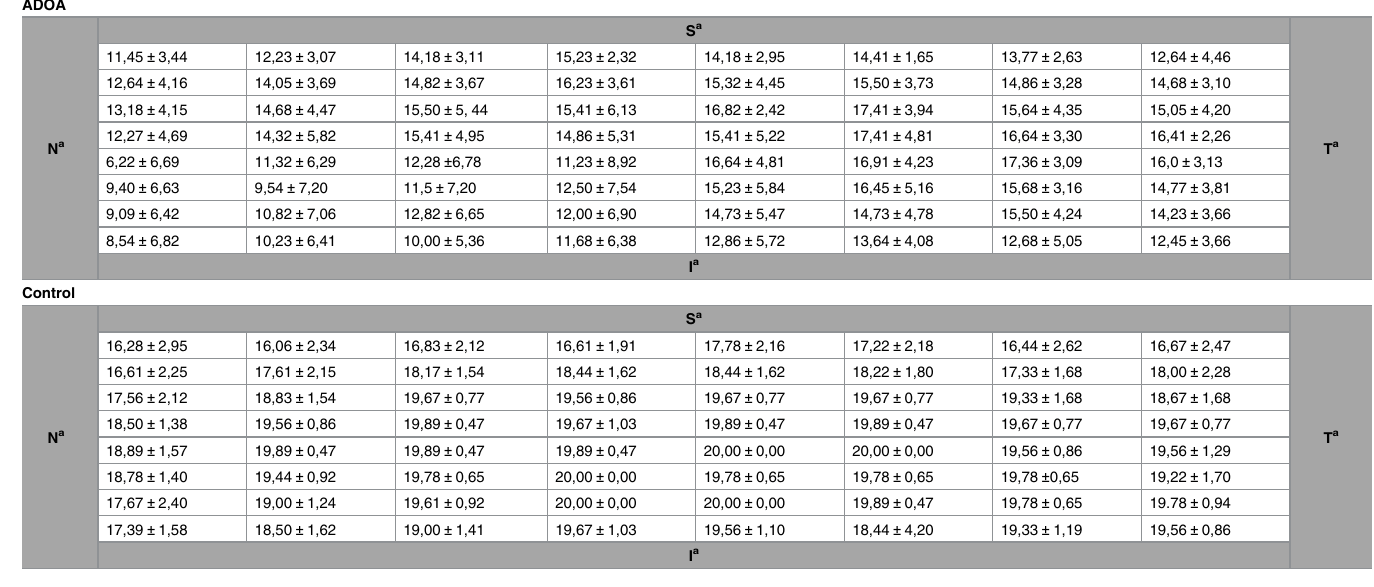
Table 4. Mean ± standard deviation retinal sensitivity values of the 64 test-points measuredby the MP1 “posterior pole” program in Autosomal- Dominant Optic Atrophy (ADOA) and Control Subjects. ADOA